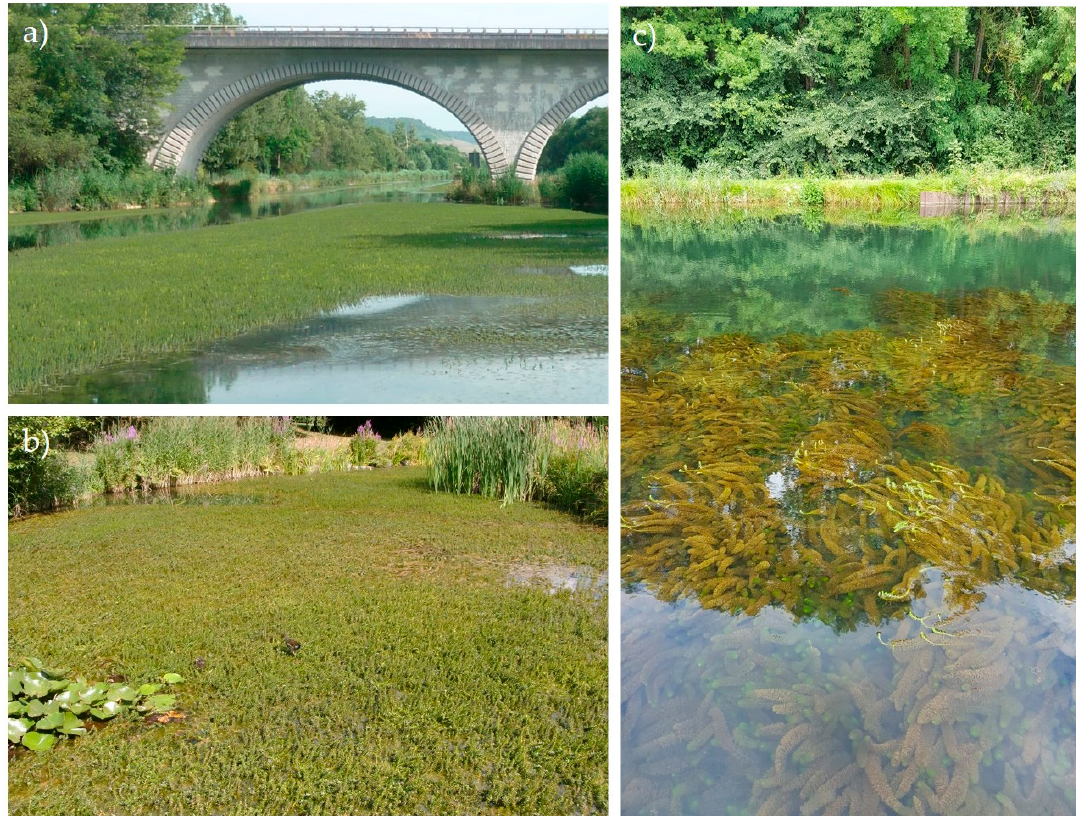
Figure 1. Systems invaded by Myriophyllum heterophyllum . ( a , c ) navigation channels in Northeast France (Photos C. Pestelard); ( b ) pond on the campus of Düsseldorf University, Germany (Photo A. Hussner).